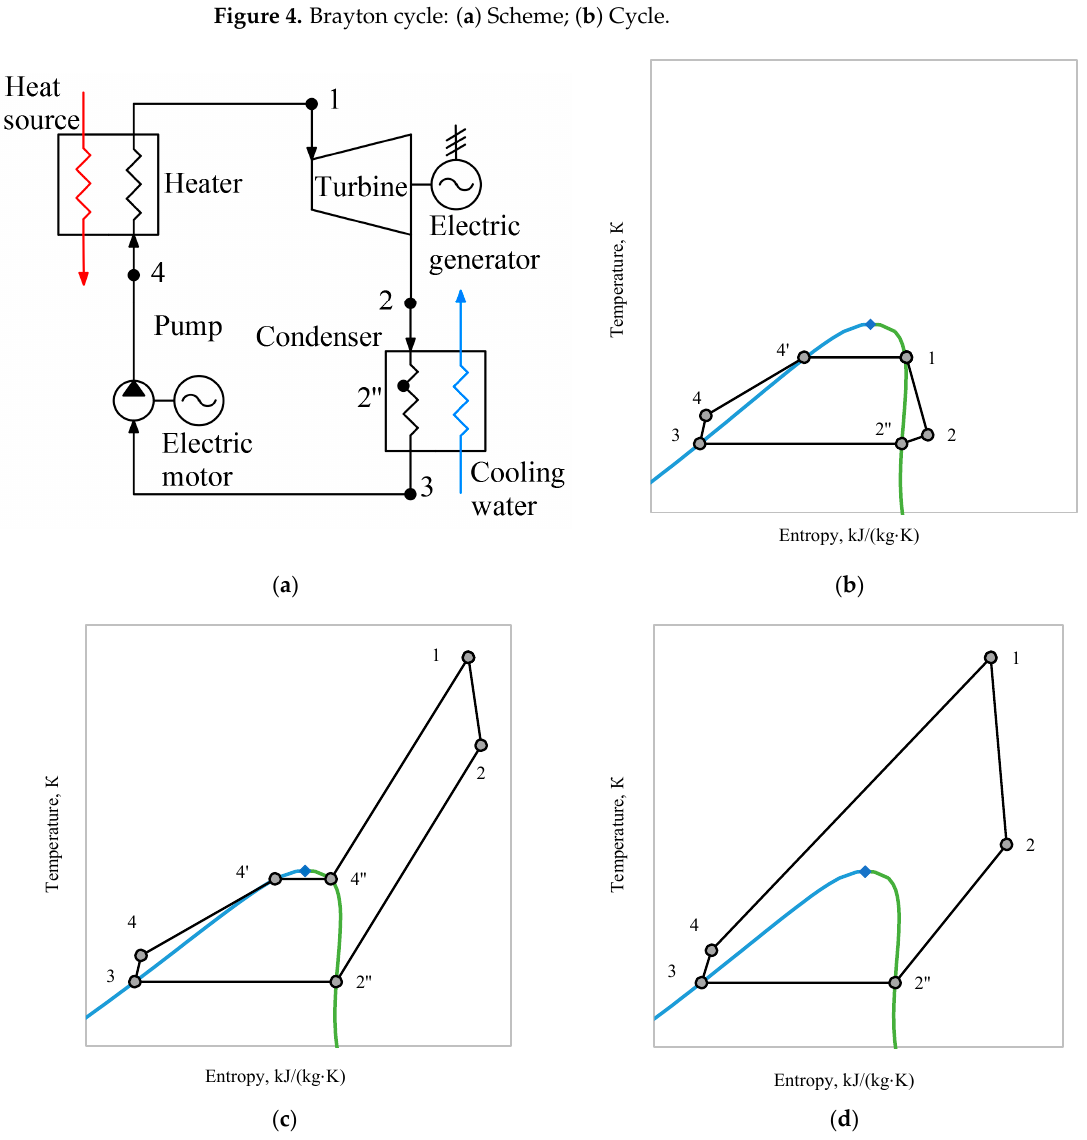
Figure 5. Rankine cycles: ( a ) Scheme; ( b ) Saturated subcritical cycle; ( c ) Superheated subcritical cycle; ( d ) Supercritical cycle.